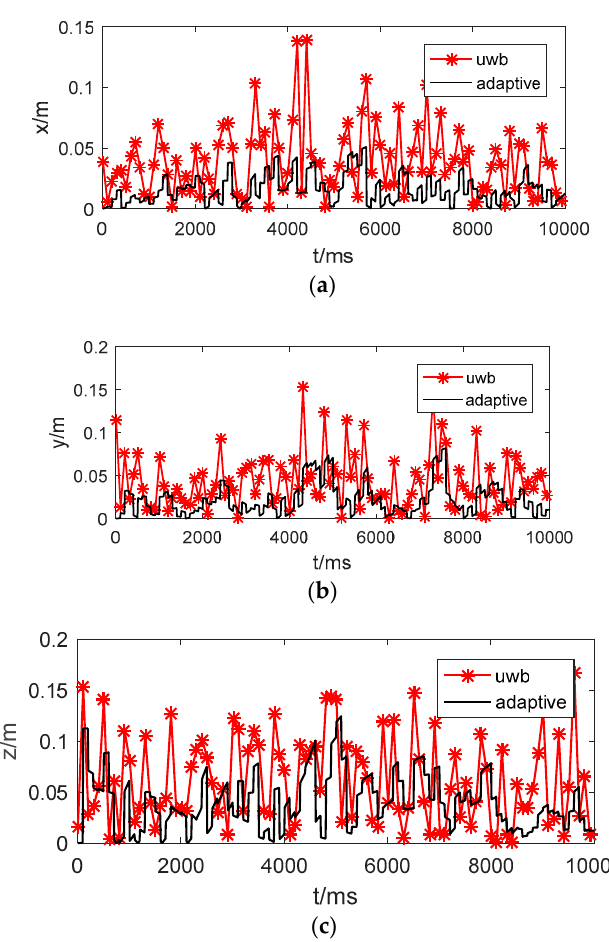
Table 3. Maximum errors of different methods. Figure 12. Position errors of the UWB and proposed strategy in three directions. ( a ) Position error along the x axis; ( b ) position error along the y axis; ( c ) position error along the z axis. Table 2. Mean errors of different methods.